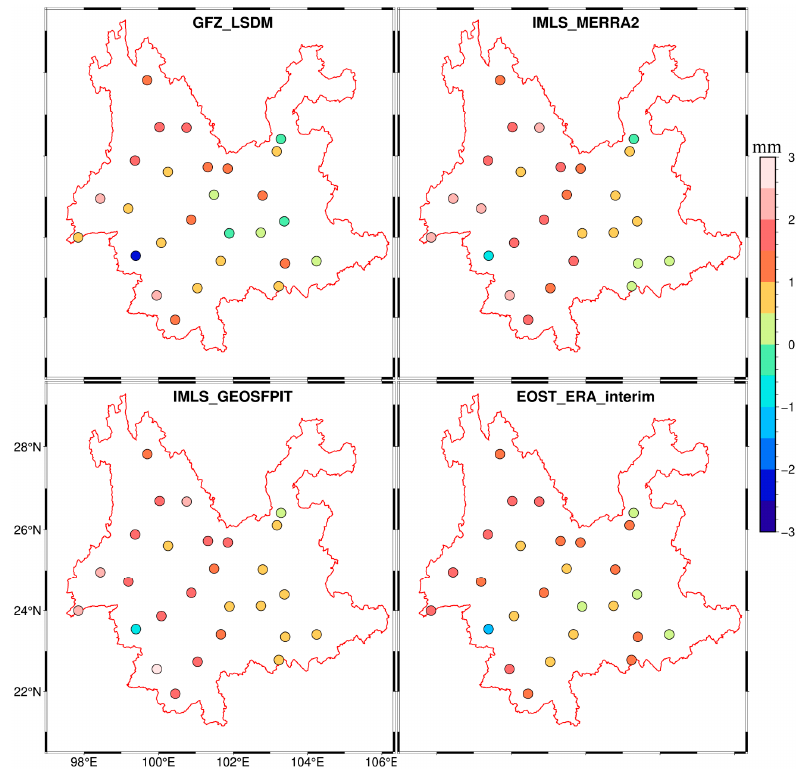
Figure 5. The RMS reductions at 27 GPS stations after four different HYDL products correction.